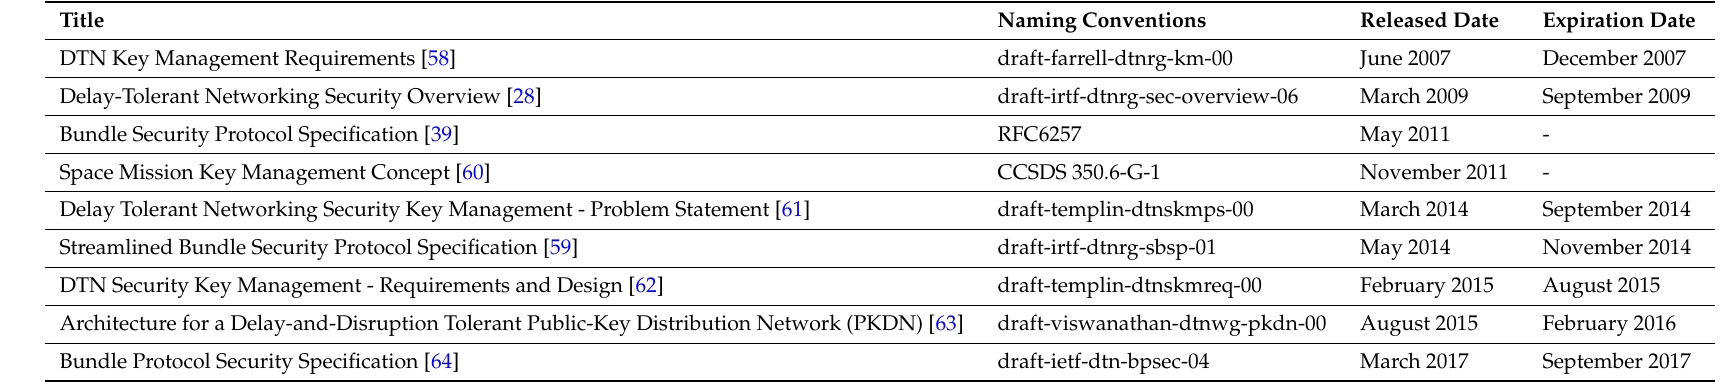
Table 6. Security-related internet drafts and